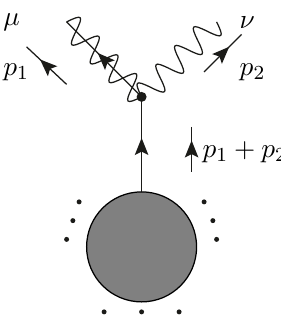
Figure 7 . Feynman diagrams leading to soft gravitino